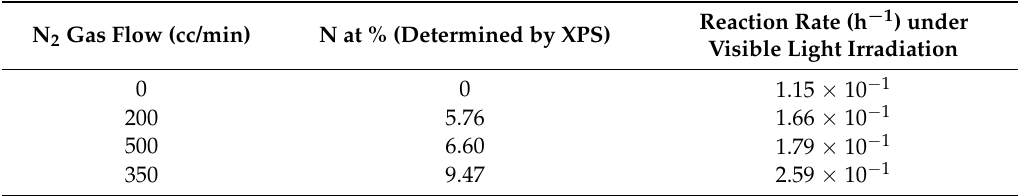
Table 1. N atomic concentration and reaction rate constant ( k ) in 0.5 ppm methylene blue solution of the TNA samples annealed in various N 2 gas flows.